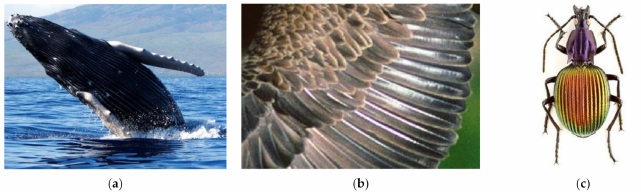
Figure 3. Sources of inspiration for the proposed technique: ( a ) leading-edge tubercles on the fin of humpback whale; ( b ) trailing edge profile of bird wing; ( c ) strips on the body surface of